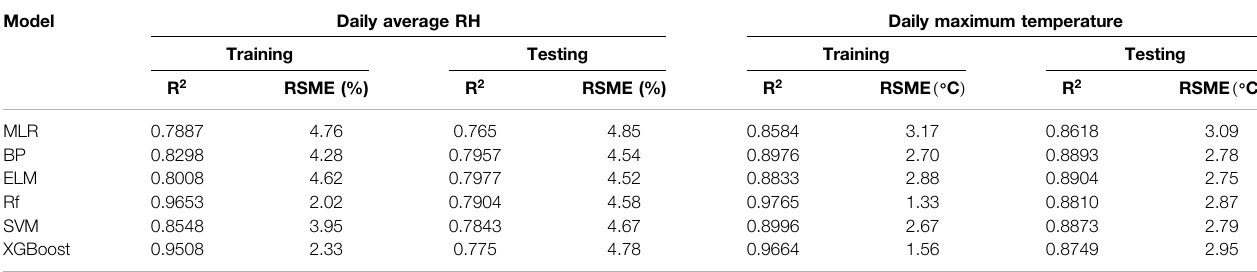
TABLE 4 | Performance of the machine learning methods.